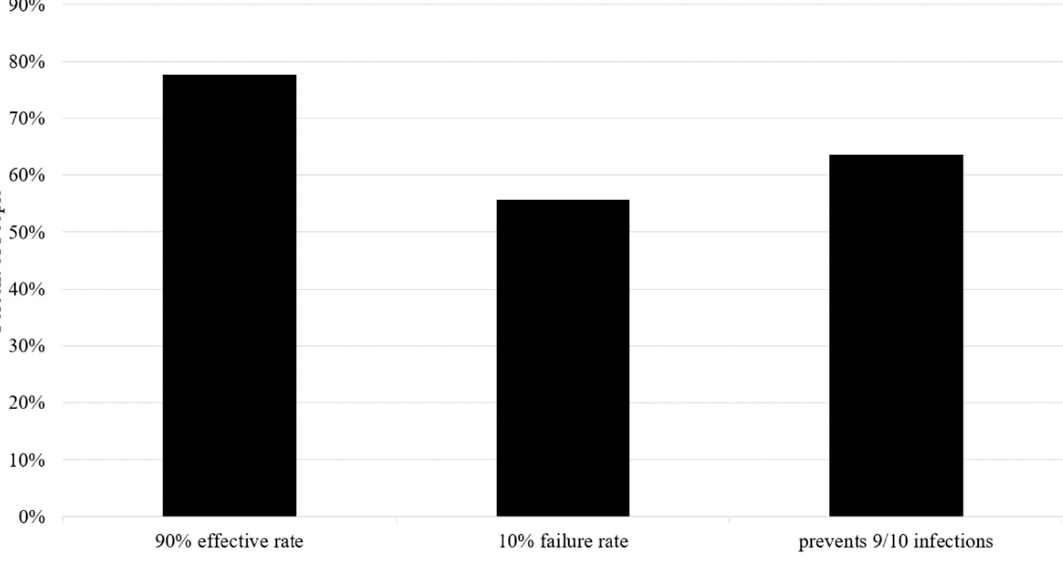
Figure 5. Which vaccine would you